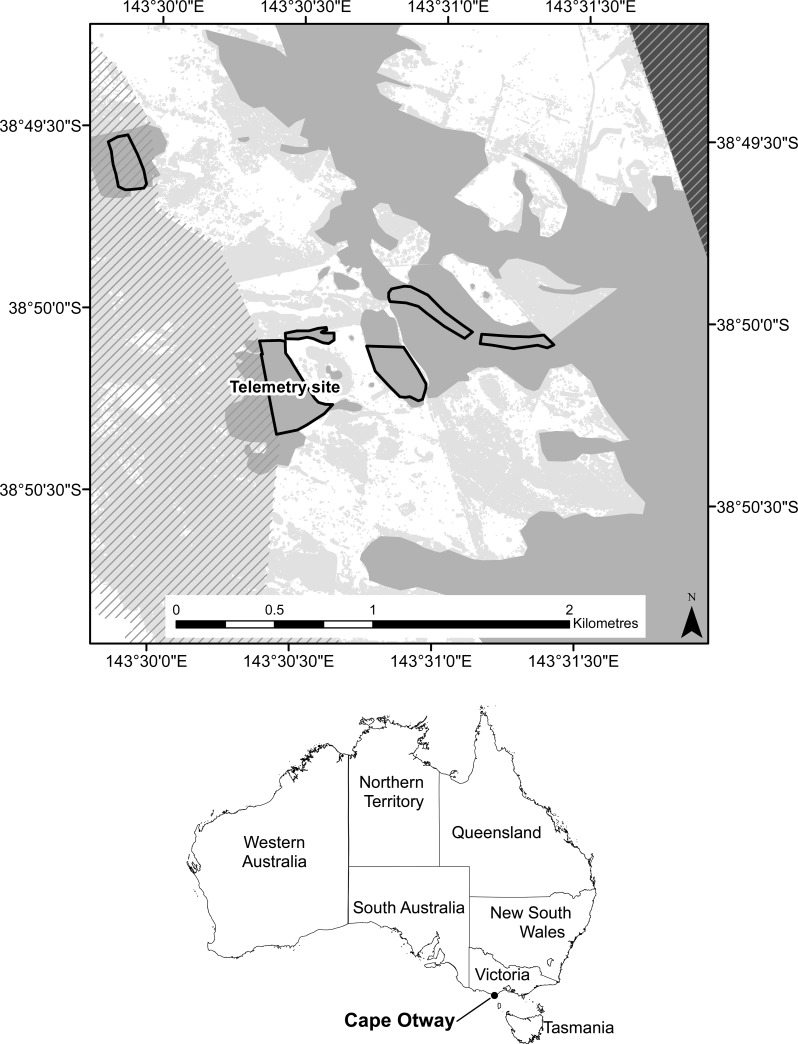
The study area in Victoria, Australia.The hatched areas are part of the Great Otway National Park. Vegetation types are coastal shrubland (light grey) manna gum woodland (medium grey), and mixed woodland (dark grey). Sites are outlined with a solid line.